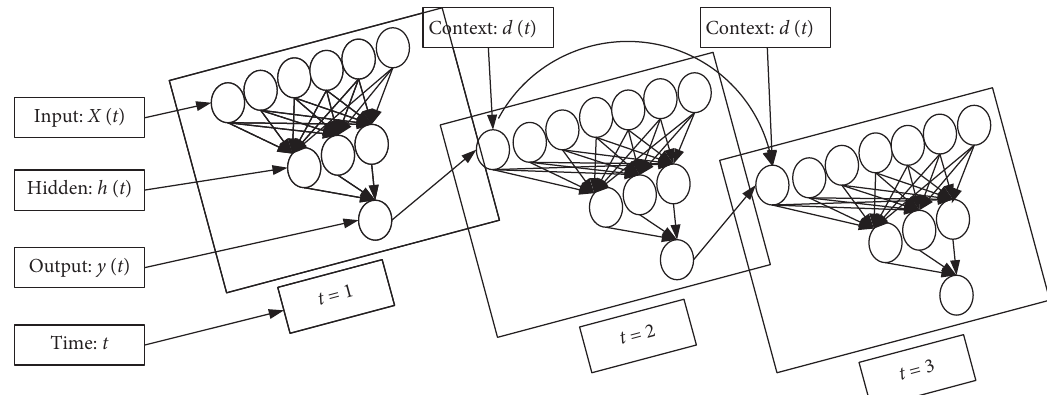
Figure 2: Details of Jordan neural network recurrent